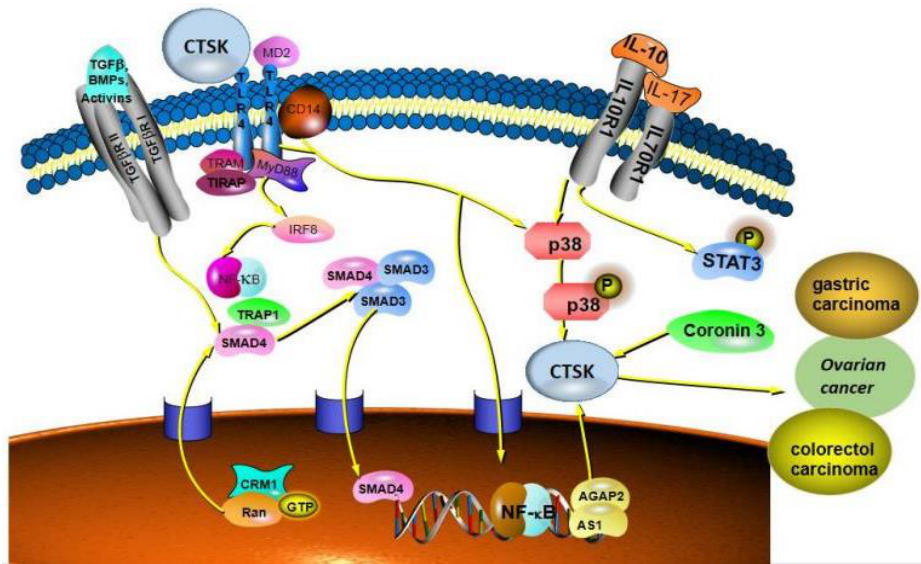
Figure 6. CTSK is strongly expressed in colorectal cancer, ovarian cancer, gastric cancer and melanoma and promotes the invasion and metastasis of these cancers. Mainly associated with the TLR signaling pathway, CTSK binds to the TLR4 receptor and activates the pathway to function.